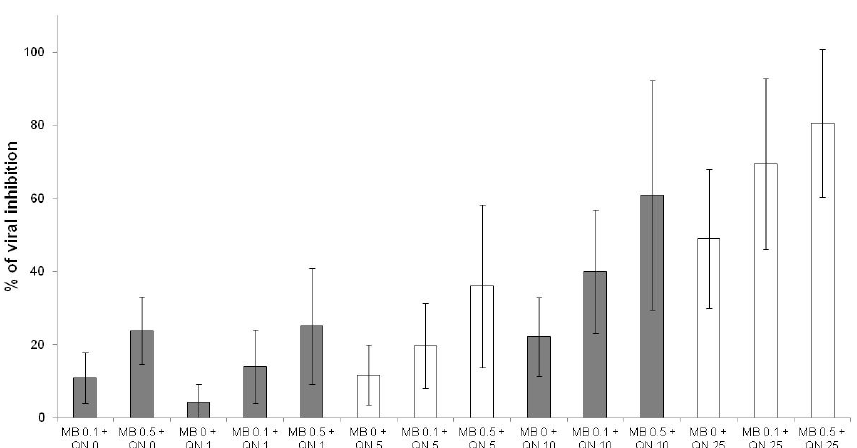
Figure 3. Antiviral activities of methylene blue (MB) at 0.1 and 0.5 µ M in combination with quinine (QN) at 1, 5, 10 and 25 µ M (error bars represent standard deviation of 13 independent